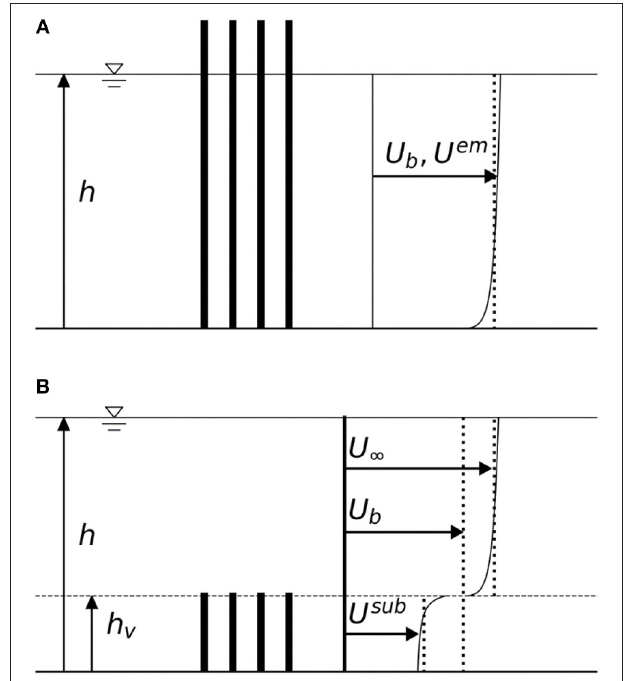
FIGURE 1 | Open channel flows with (A) an emergent canopy and (B) a submerged canopy. In emergent canopies, the depth-averaged velocity ( U ) is often used as the representative in-canopy velocity scale ( U em ). In submerged canopies, the depth-averaged velocity inside the canopy ( U sub ) is often substantially reduced from the above-canopy (free stream) velocity ( U